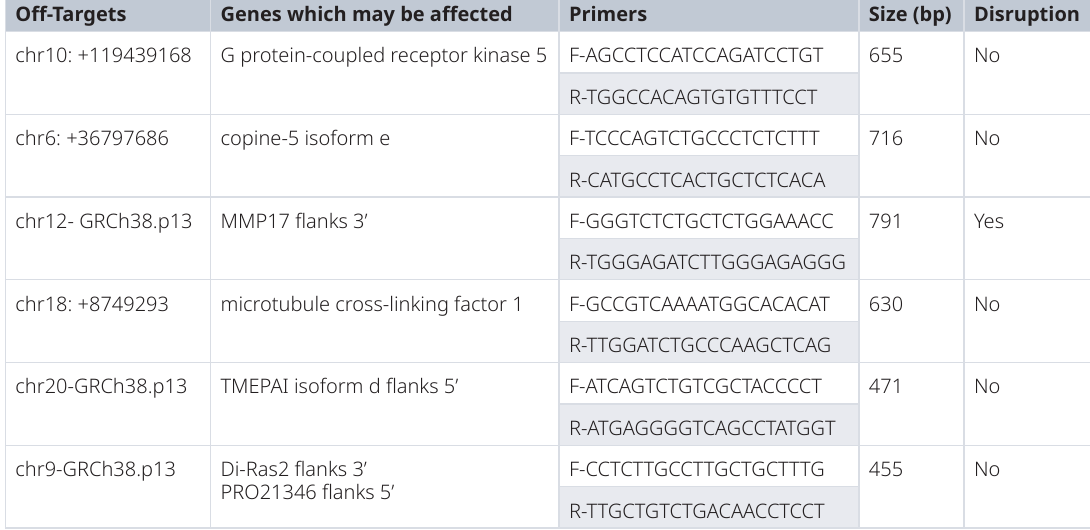
Table 1. Selected off targets for crRNA GGGGCCACTAGGGACAGGAT (PAM TGG). Oligonucleotide primers designed to amplify these off-target sites to verify off target disruptions.